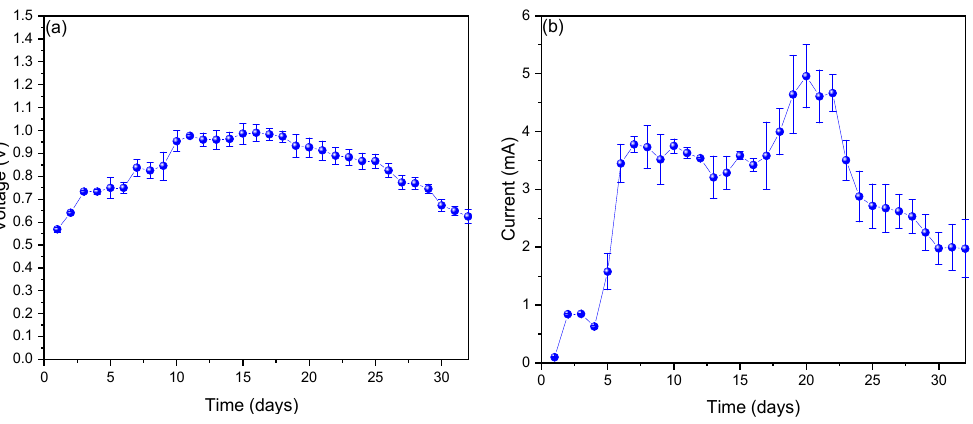
Figure 1. Monitoring of ( a ) voltage and ( b ) current values of microbial fuel cells (MFCs).